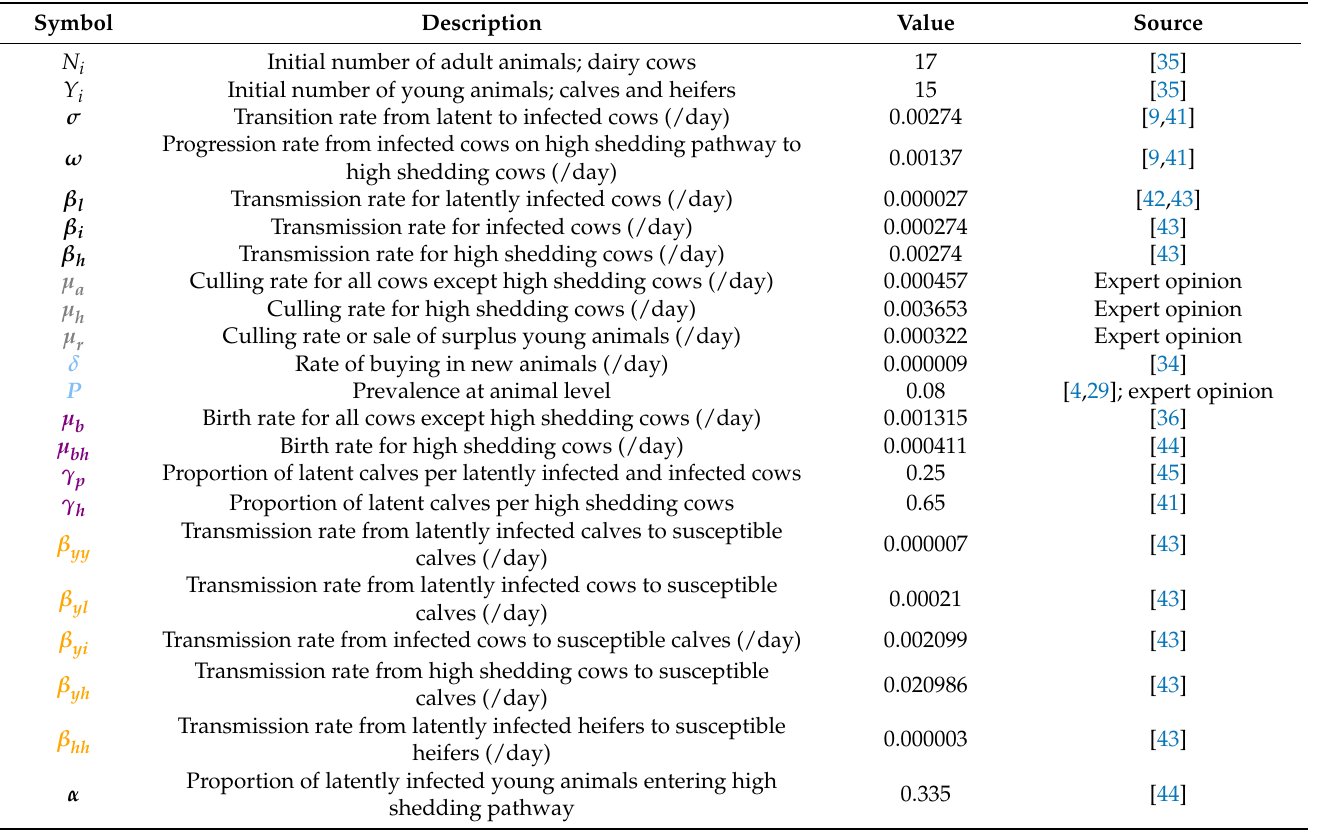
Table 1. Parameters of the model for the spread of Mycobacterium avium subsp. paratuberculosis in a typical Slovenian dairy herd.